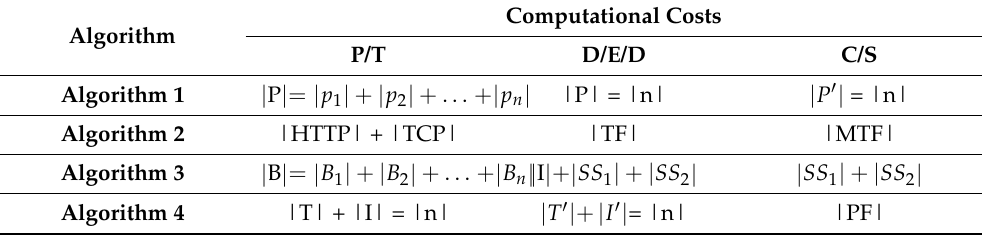
Table 1. Computational cost analysis.